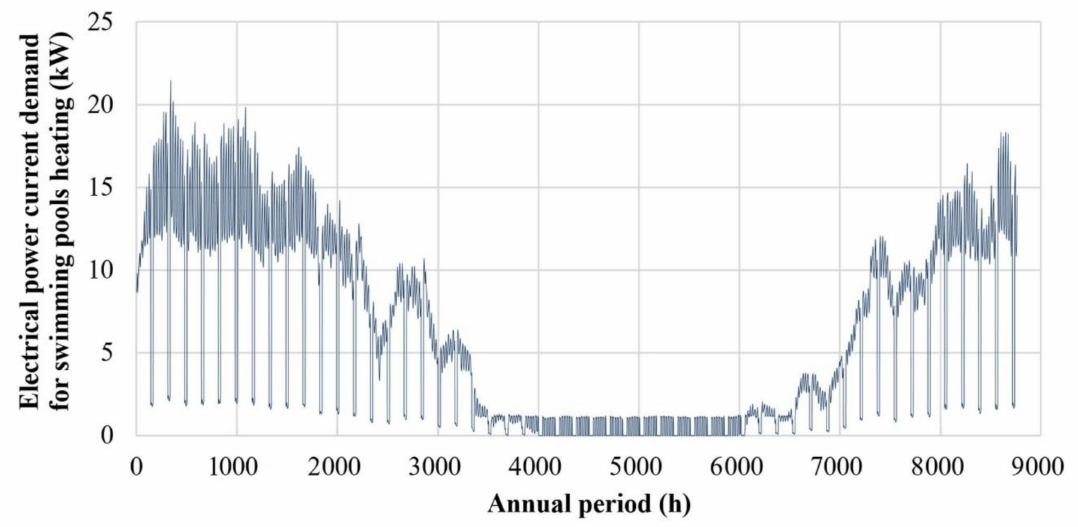
Figure 6. Annual fluctuation of electricity demand for the swimming pools heating in the existing